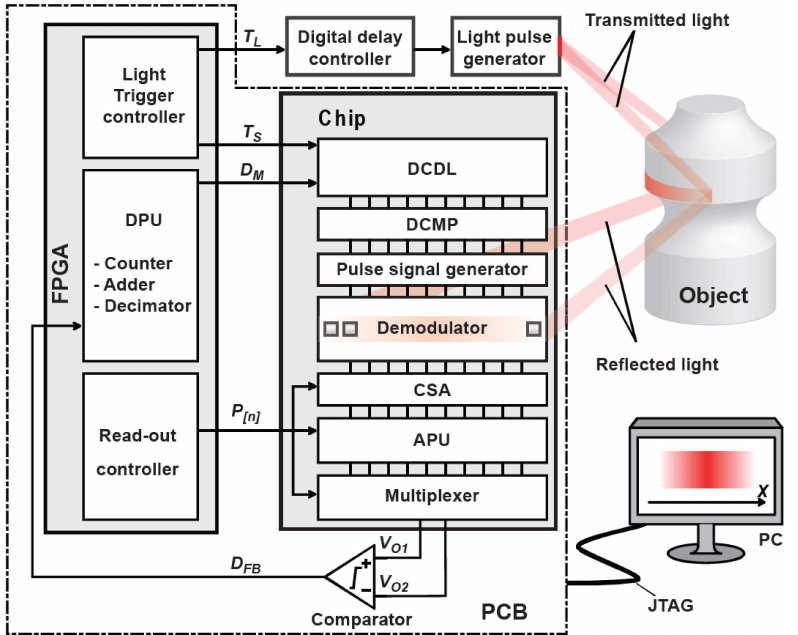
Figure 13. A measurement setup for demonstrating the proposed ToF measurement system.